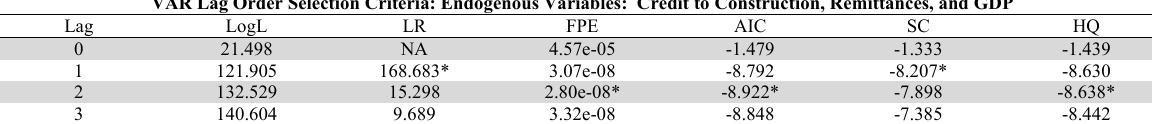
VAR Lag Order Criteria